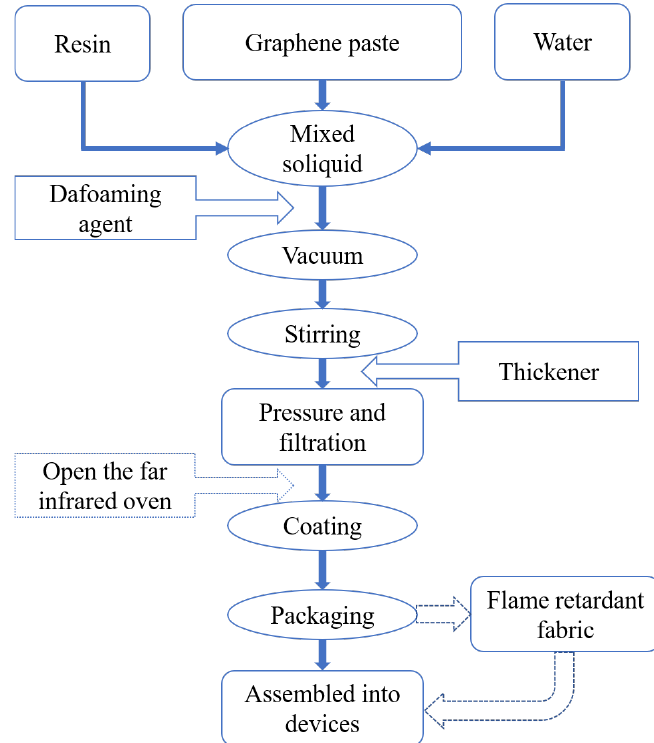
Figure 1. Flow chart of the graphene heating device prepared by the FFGS method. Using the FFGS technique, we successfully fabricated a novel graphene far-infrared transmitter device with adjustable dimensions (Figure 2). The graphene heating device consists of three parts: the graphene film, the intelligent temperature controller, and the power adopter. It offers several advantages for infrared healthcare products: (1) it allows direct contact with the skin and can be heated automatically with adjustable temperature and voltage; (2) it has high intensity and abrasion resistance; (3) it can be prepared into different shapes to fit different parts of the human body; and (4) it exhibits high far-infrared emission efficiency and provides a comfortable warmth sensation.